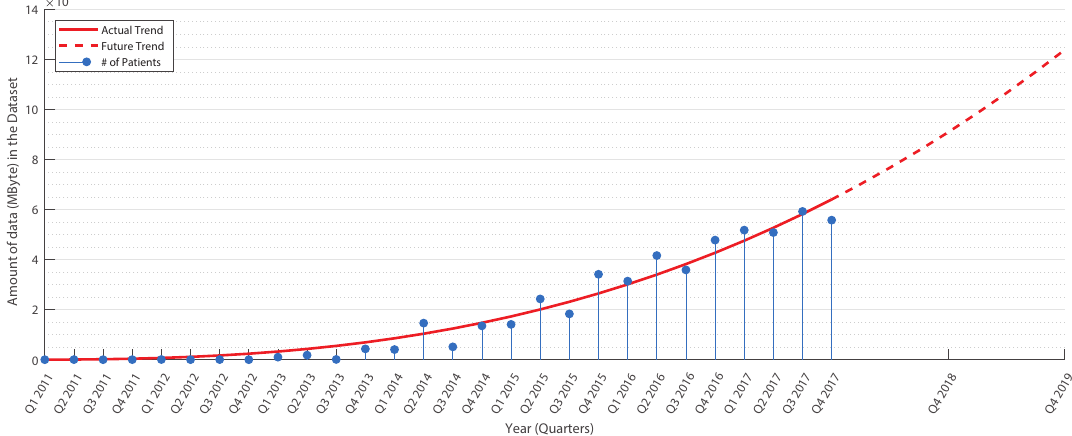
Figure 1. Data production in a medium-sized medical center (see Section 4.7). The tendency curve (in red) shows the estimation for future